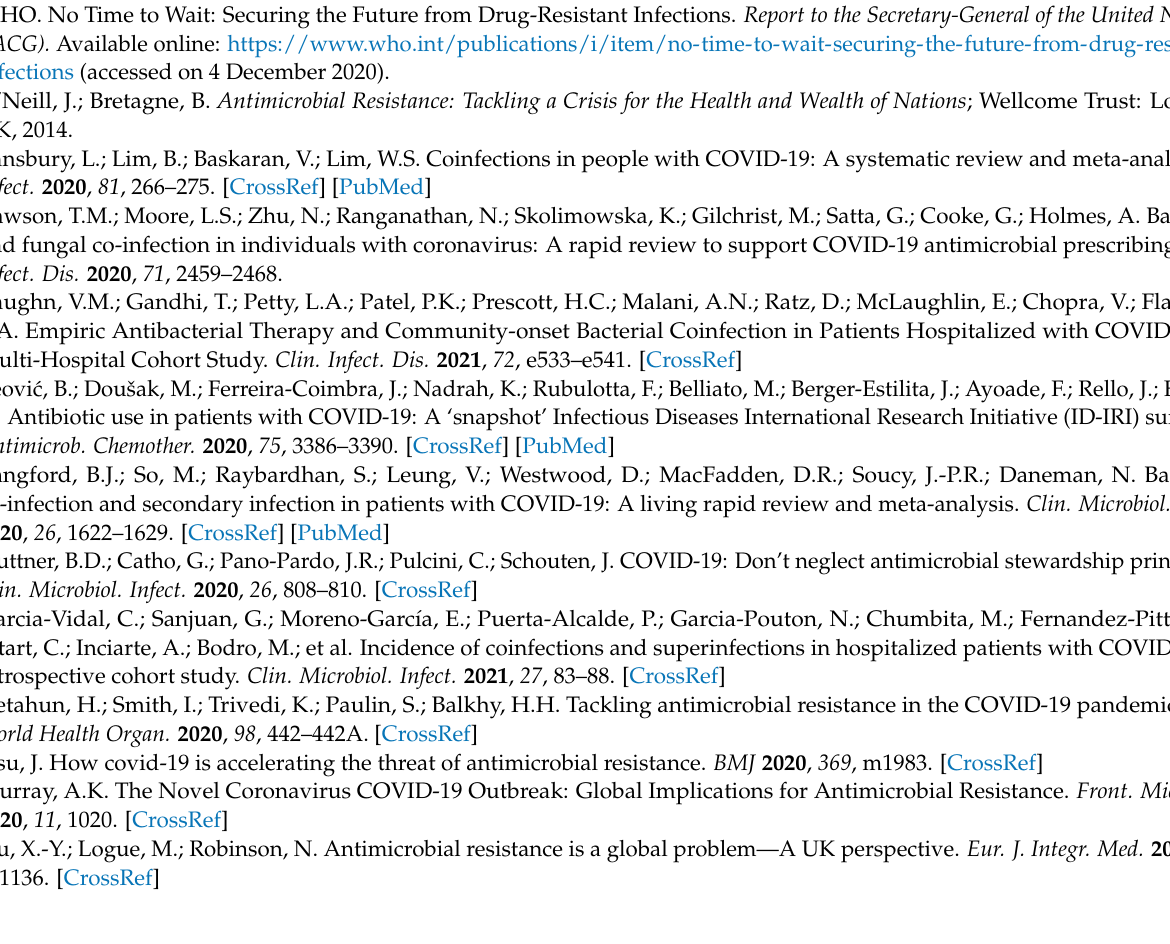
mentary Table S2: Severity of illness and scenario of antibiotic prescribing; Supplementary Table S3: Types of study based on gender and health outcomes (LOS, discharge and mortality); Supplementary Table S4: Antibiotic prescribing, length of stay, discharge rate and mortality rate by study designs; Supplementary Table S5. Antibiotic prescribing, length of stay, discharge rate and mortality rate by income of the study countries. Annex 1 References list included for this